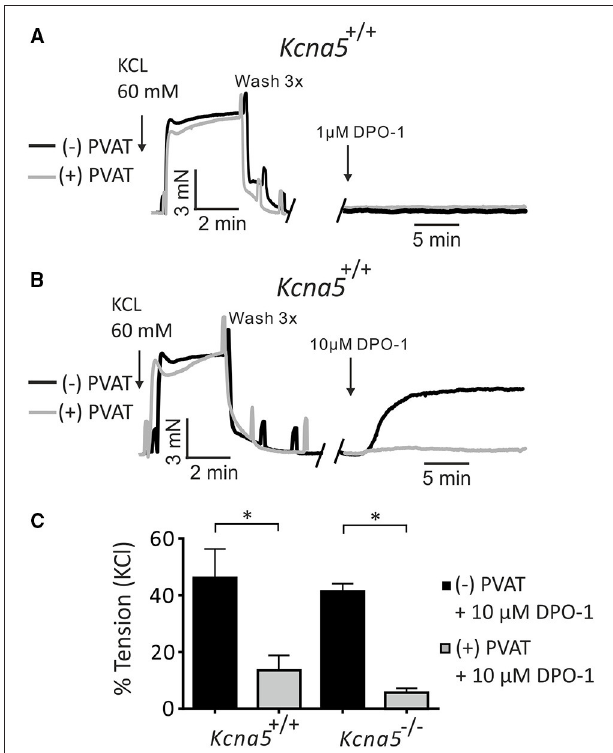
FIGURE 2 | Effects of 1 µ M and 10 µ M DPO-1 on basal arterial tone of mesenteric artery rings isolated from Kcna5 + / + and Kcna5 − / − mice. Original traces showing contraction of mesenteric ( − ) and ( + ) PVAT rings induced by 60mmol/L KCl and by 1 µ M ( A ) and 10 µ M DPO-1 ( B ). ( C ) Vessel tension induced by 10 µ M DPO-1. Tension is expressed as a percentage of KCl contractions. Kcna5 + / + ( − ) PVAT, n = 9; ( + ) PVAT, n = 13. Kcna5 − / − ( − ) PVAT, n = 7; ( + ) PVAT, n = 9. * p < 0.05, two-way ANOVA followed by Bonferroni post hoc